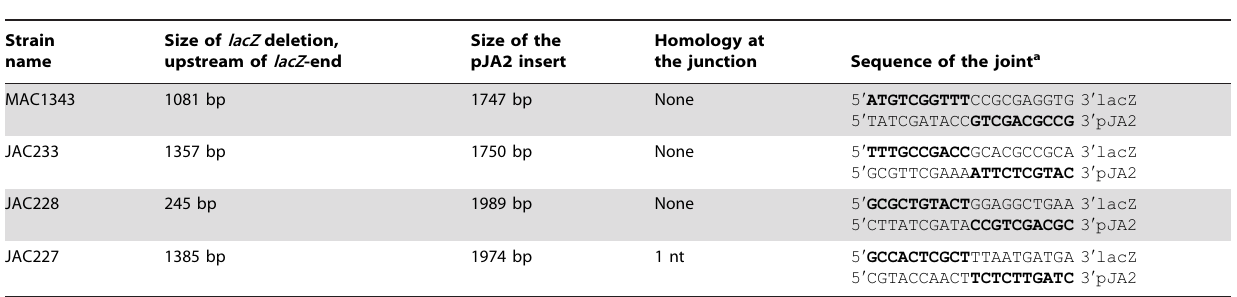
a The joint is composed of the concatenation of the two bold sequences from each parent. doi:10.1371/journal.pone.0028876.t003 PLoS ONE |